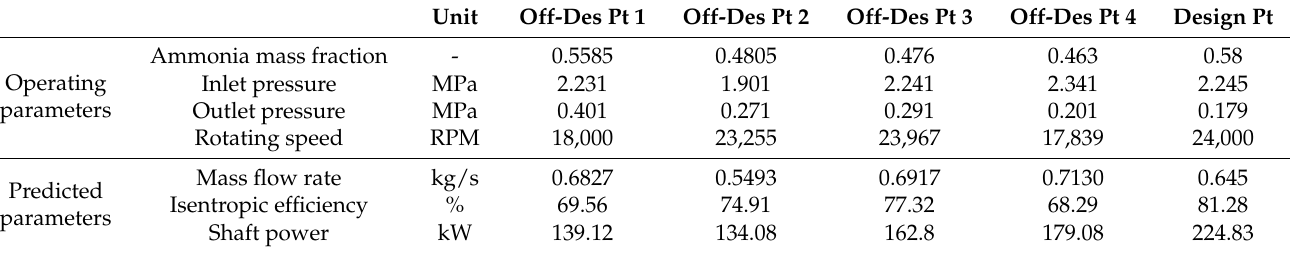
Table 4. The off-design operating conditions and predicted performance parameters.